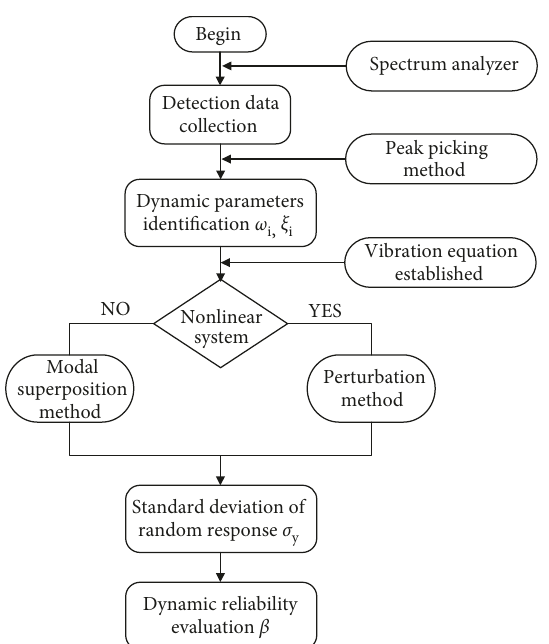
Figure 7: Flowchart of procedure for reliability evaluation on the foundation of stone cutting machine.